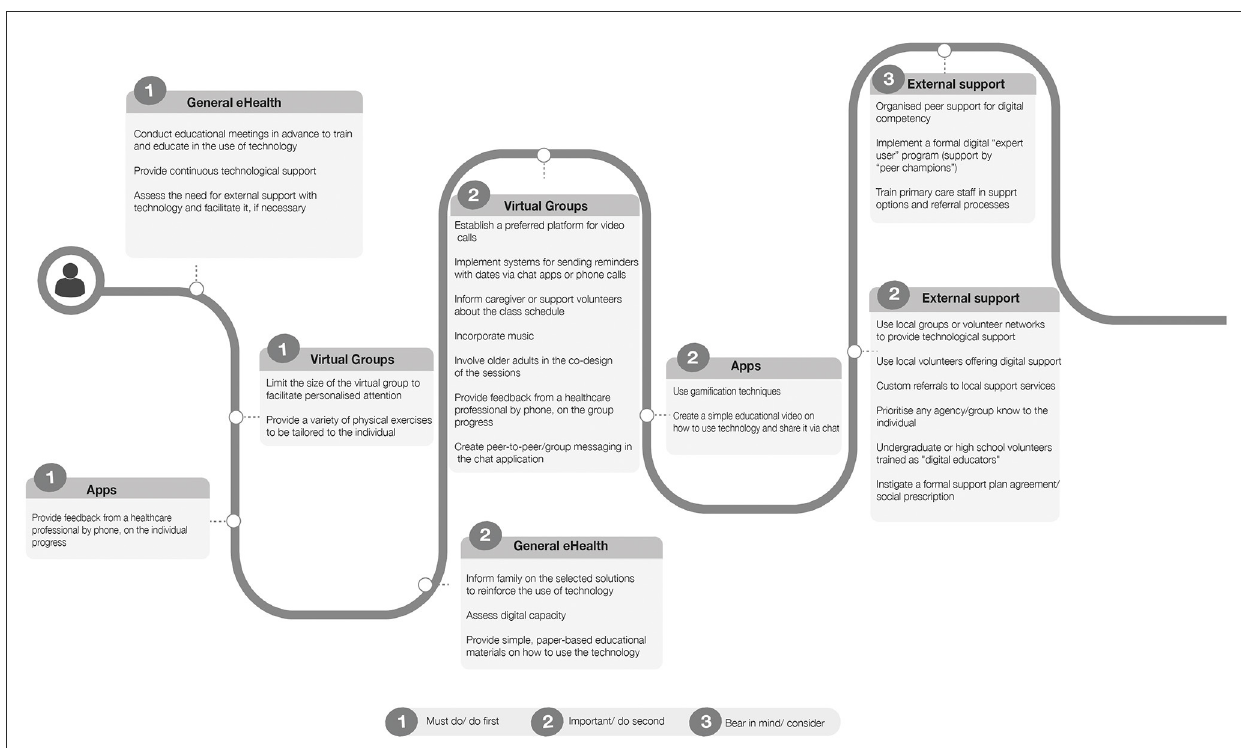
FIGURE4 Graphic representation of the main suggestions from all groups, plotted along an ideal timeline, from the preparation to the execution of the mHealth solution to foster physical